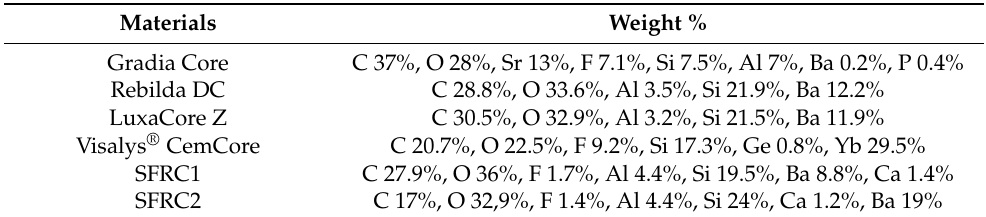
Table 2. Major elements of particles of investigated resin composites determined with EDS